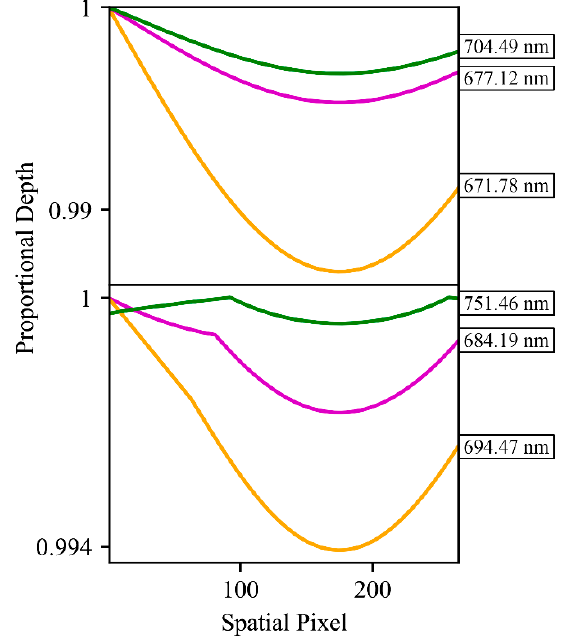
Figure 17. Examples of absorption feature proportional depths (colored lines and valley wavelength labelled) changing over the spatial pixels of FIREFLY as a result of the variation in FWHM.